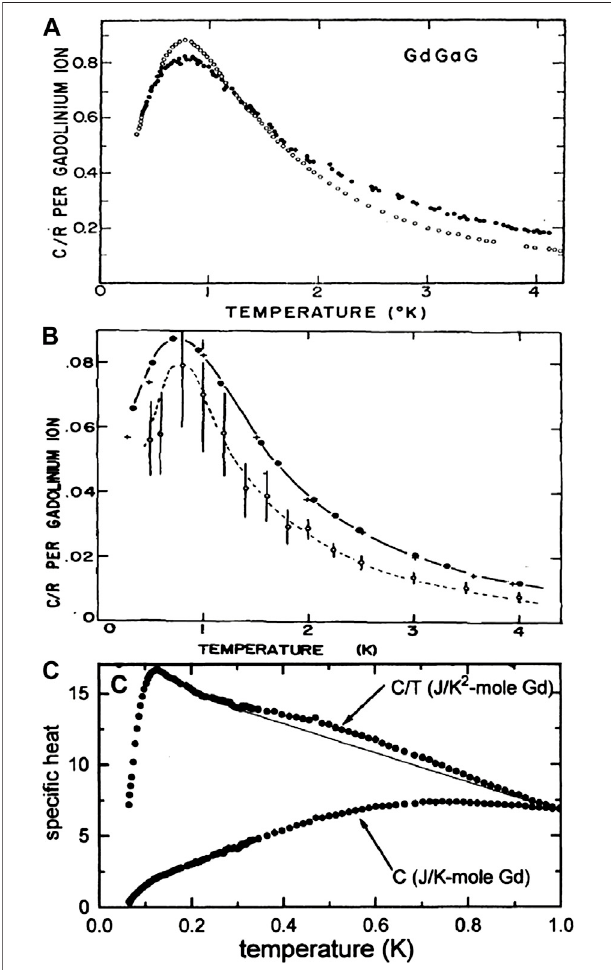
FIGURE 4 | (A) Speci fi c heat of two samples of GGG, full marks: Sintered sample, open marks: cluster of single crystals [9]. (B) Temperature dependence of the speci fi c heat of GGG. Solid curve and points are experimental results. Broken curve and points is a Monte Carlo calculation with J 1 = 0.107 K, J 2 = − 0.003 K and J 3 = 0.010 K, [10]. (C) Speci fi c heat of a single crystal GGG sample along [1 0 0] direction [15].